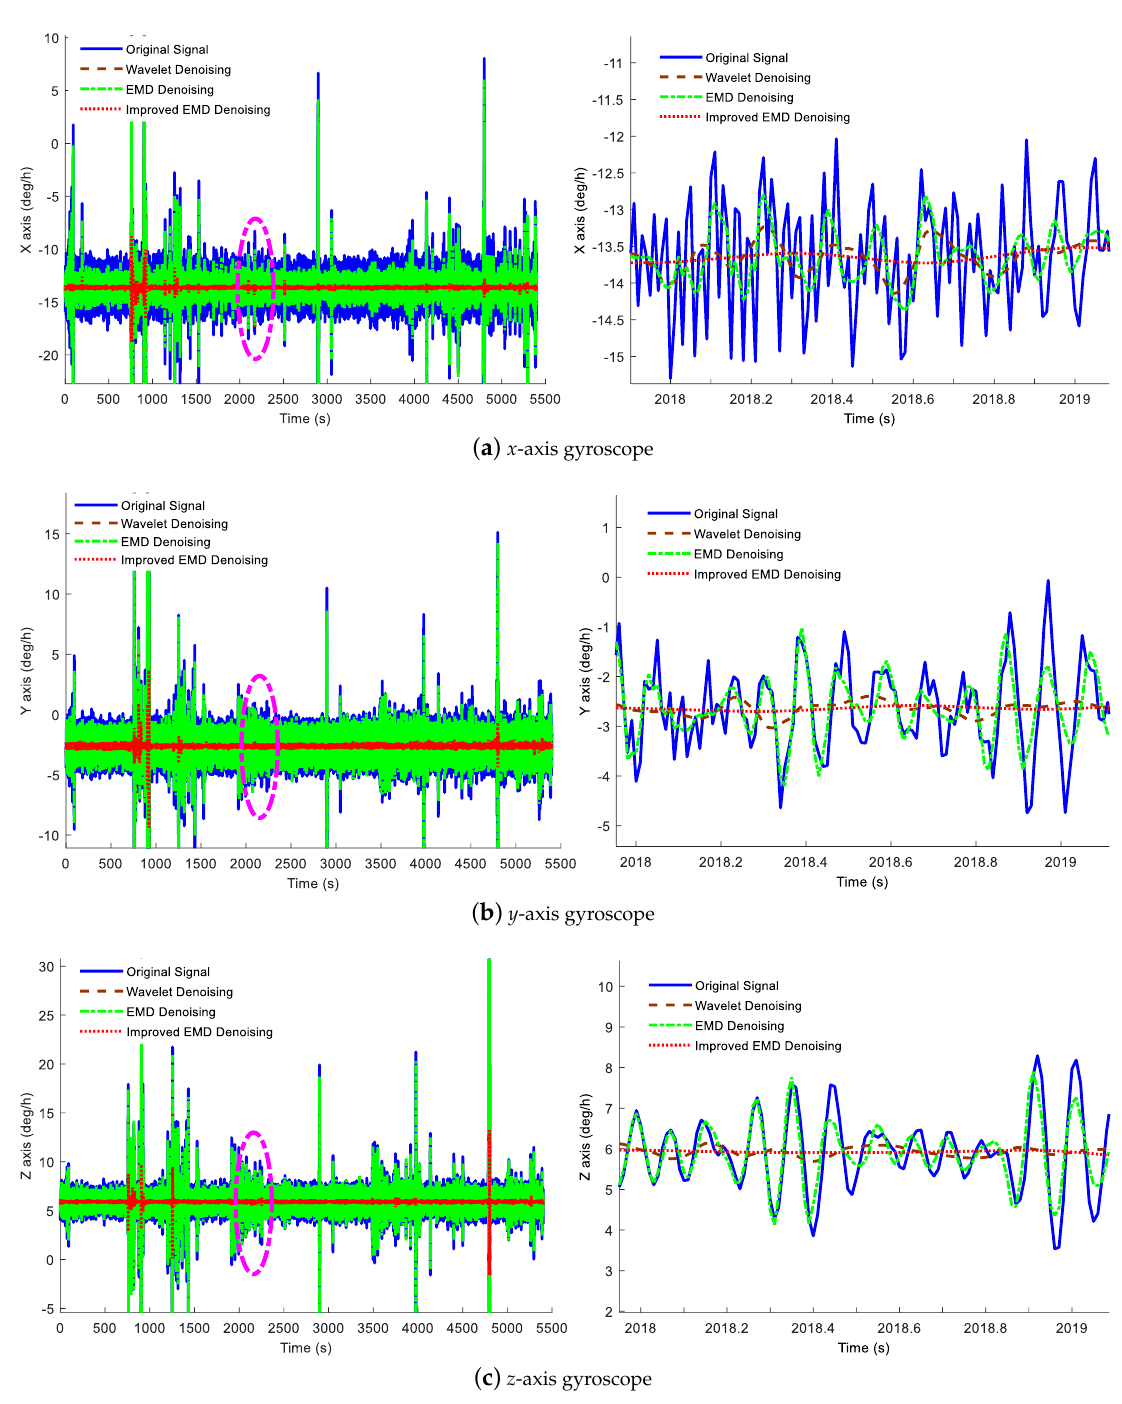
Figure 5. Gyroscope denoising result by utilizing multiple denoising methods. The left subfigures are the denoising results of the x -axis, y -axis and z -axis gyroscopes and the right subfigures are the local magnifications of the purple elliptical